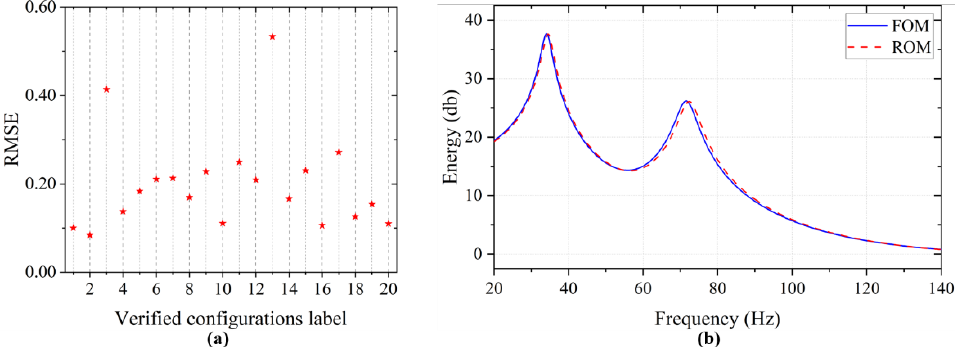
Figure 16. Accuracy of the verified configurations computed by initial global POD ROM: ( a ) RMSE values; and ( b ) energy–frequency curves of No.13 verified configuration.